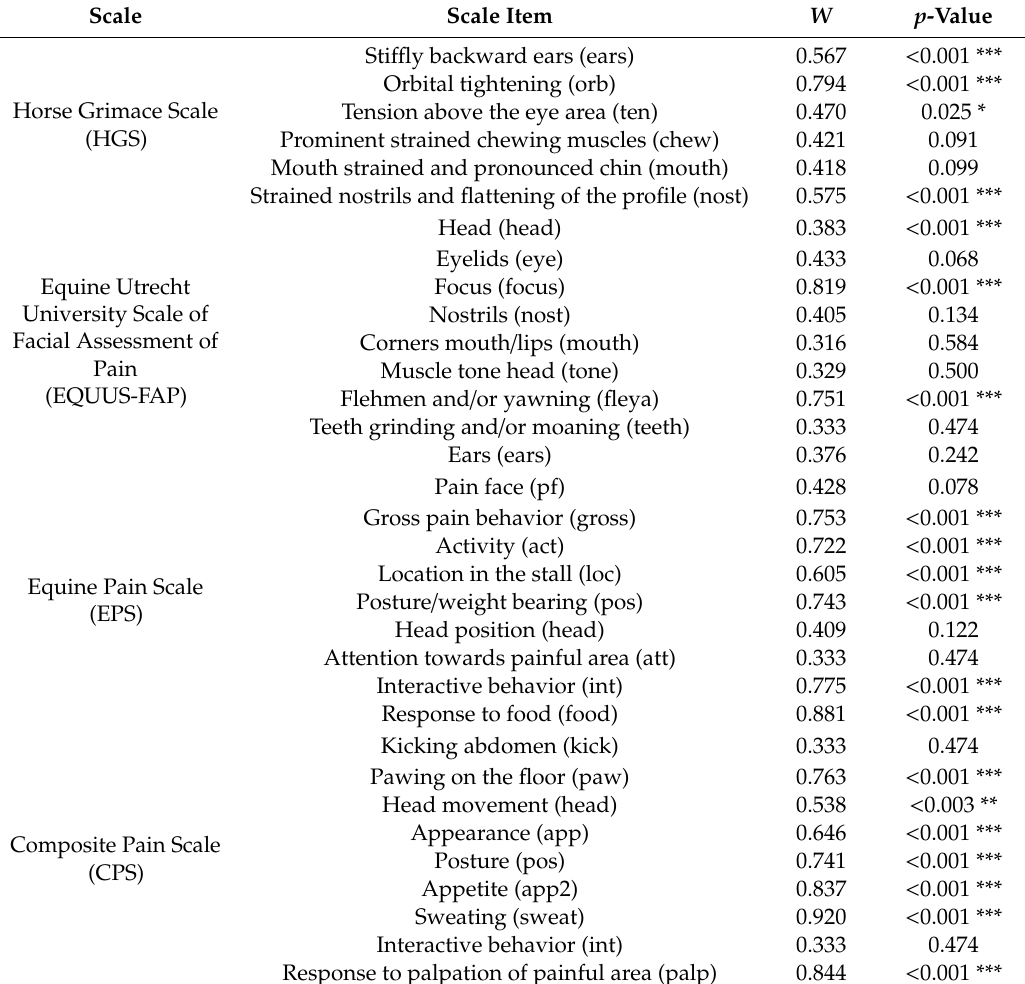
Table 1. Inter-observer agreement estimated with Kendall’s coe ffi cient of concordance ( W ) for the four pain scales tested. Pain scores for each scale item and three observers are